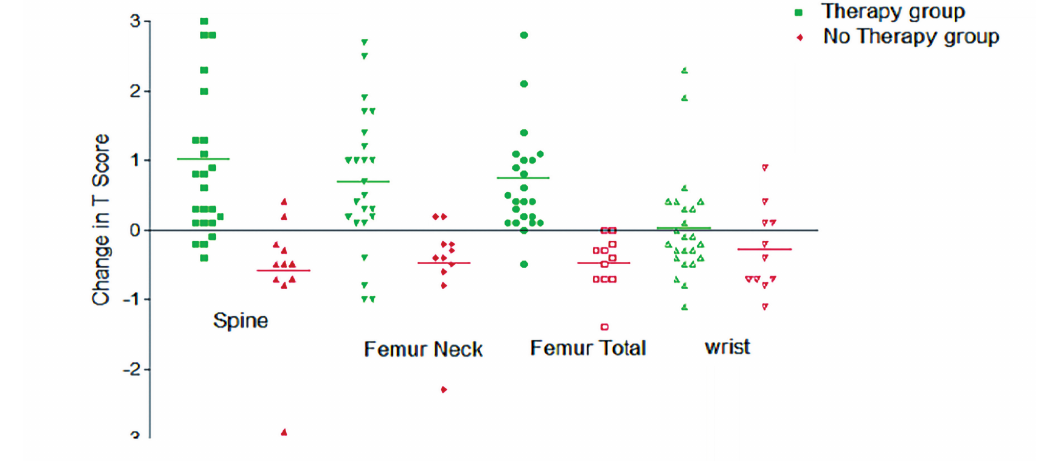
Figure 4 - Comparison of T-Scores in patients who received therapy and did not received therapy showing favourable results for therapy